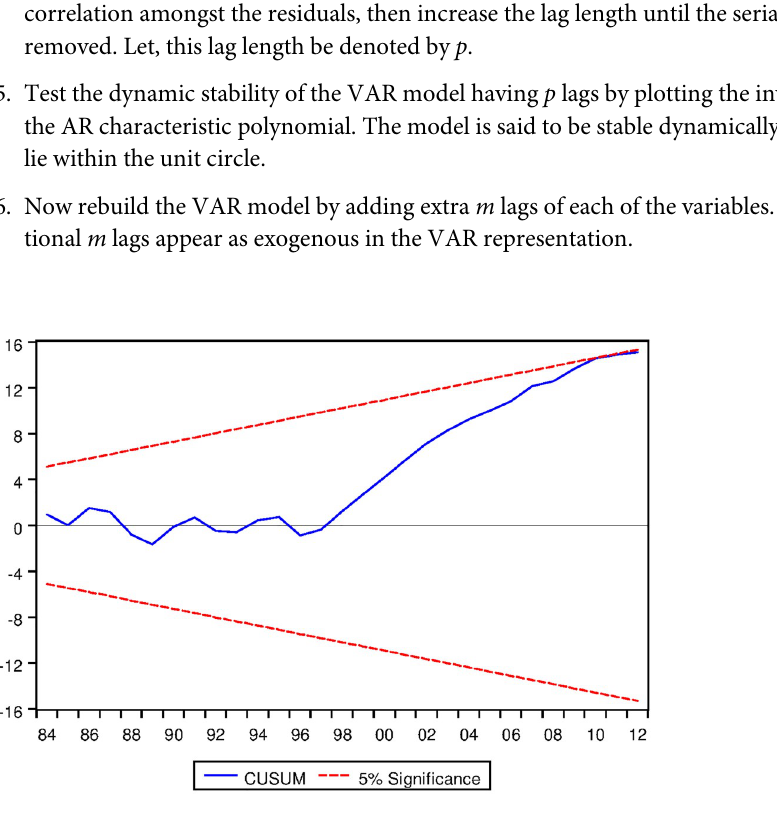
Fig 26. Stability diagnostic of cointegrating relationship for Japanese data with no fixed regressor under Fisherian framework.